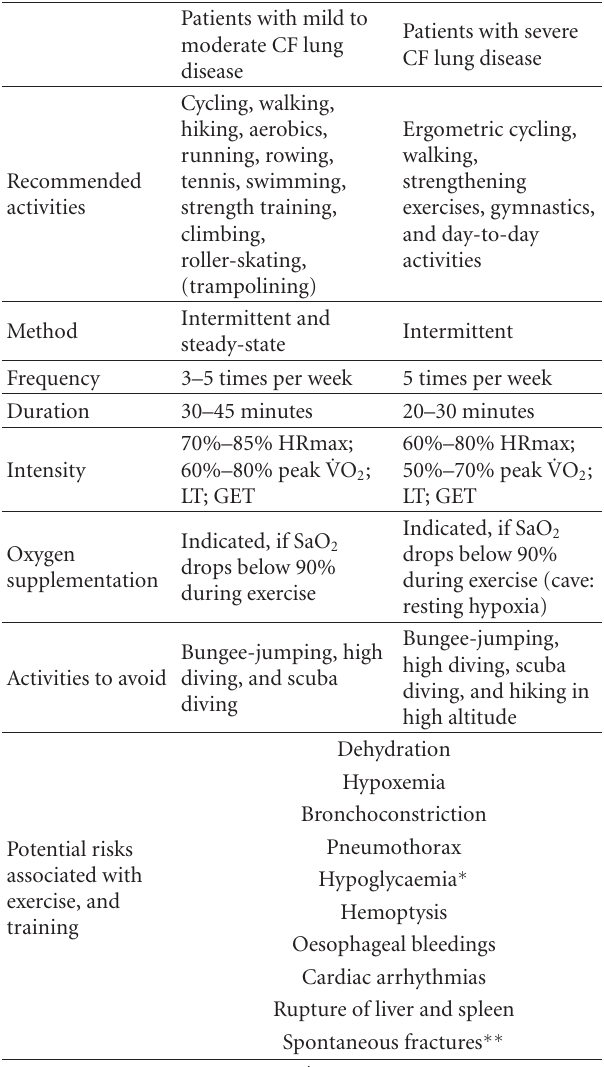
Table 1: General exercise and training